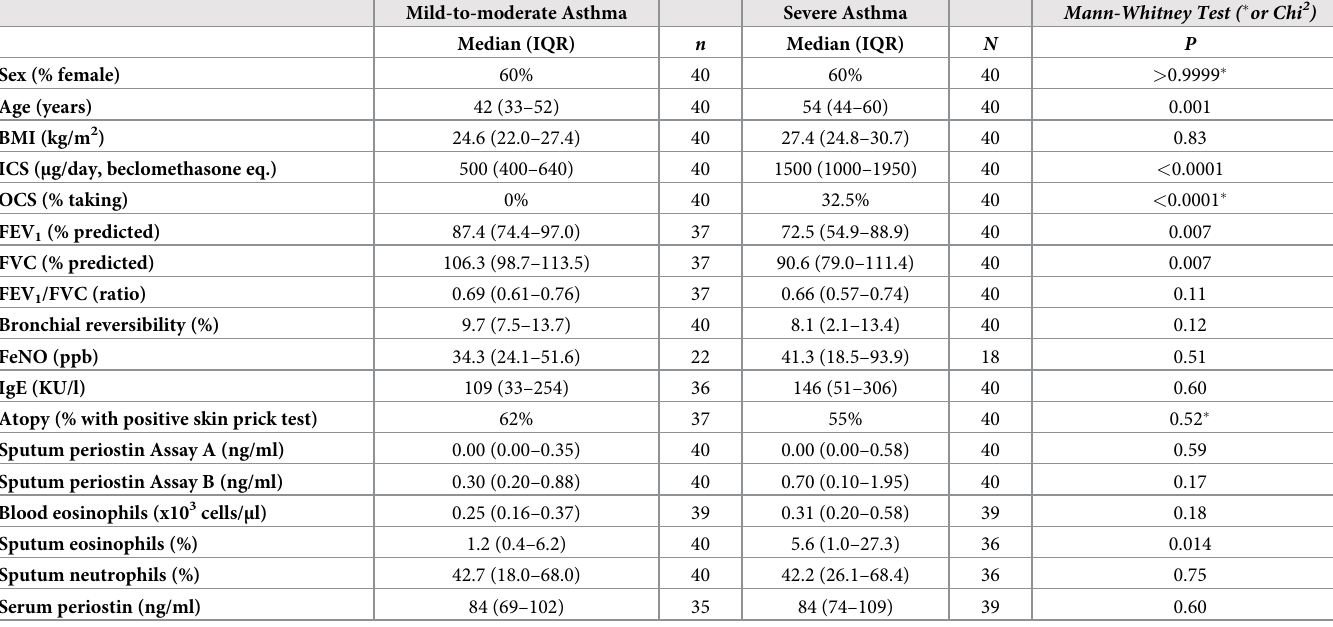
Table 1. Clinical characteristics of BIOAIR study